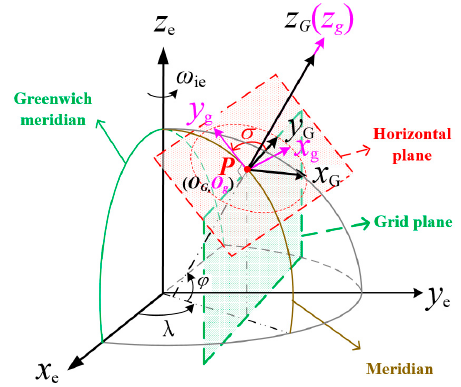
Figure 1. Description of the grid frame.